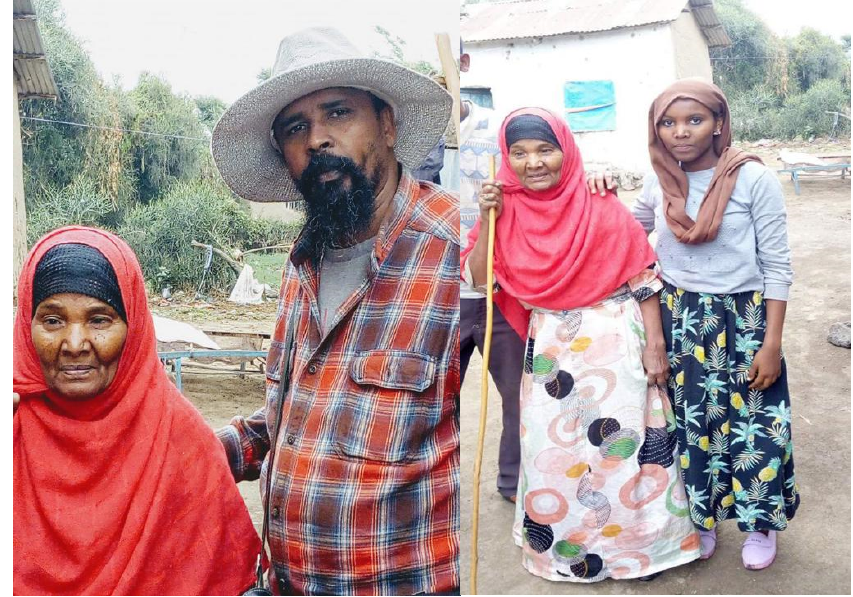
Figure 4. Ayya Ubbe, Amudde. 27 January 2020. Photo, Abadir, an assistant to the Author. Sources indicate that the Rift Valley lakes are sources of water and have environmen- tal, cultural, and economic significance (Yeshiemebet 2016; Masresha et al. 2011). Ayya Ubbee (infr.) confirmed to me that until they were prohibited by Sharia, men and women in the area went to the bank of Hara Roobii for Irreecha, a Thanksgiving festival in Birra, September. However, according to Ayya Ubbe, with the coming of a strong Islamic faith